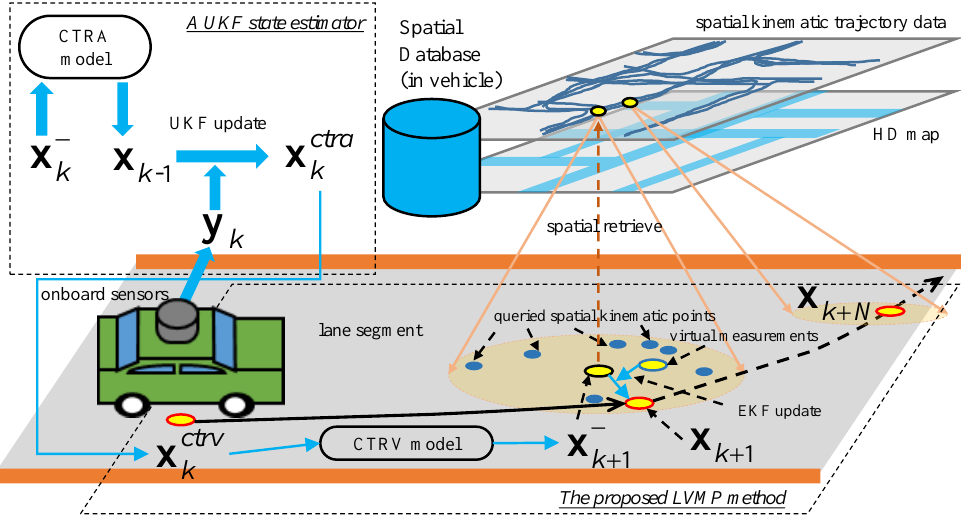
Figure 1. System overview. The idea of this paper is inspired by the first law of geography that everything is related to everything else, but near things are more related to each